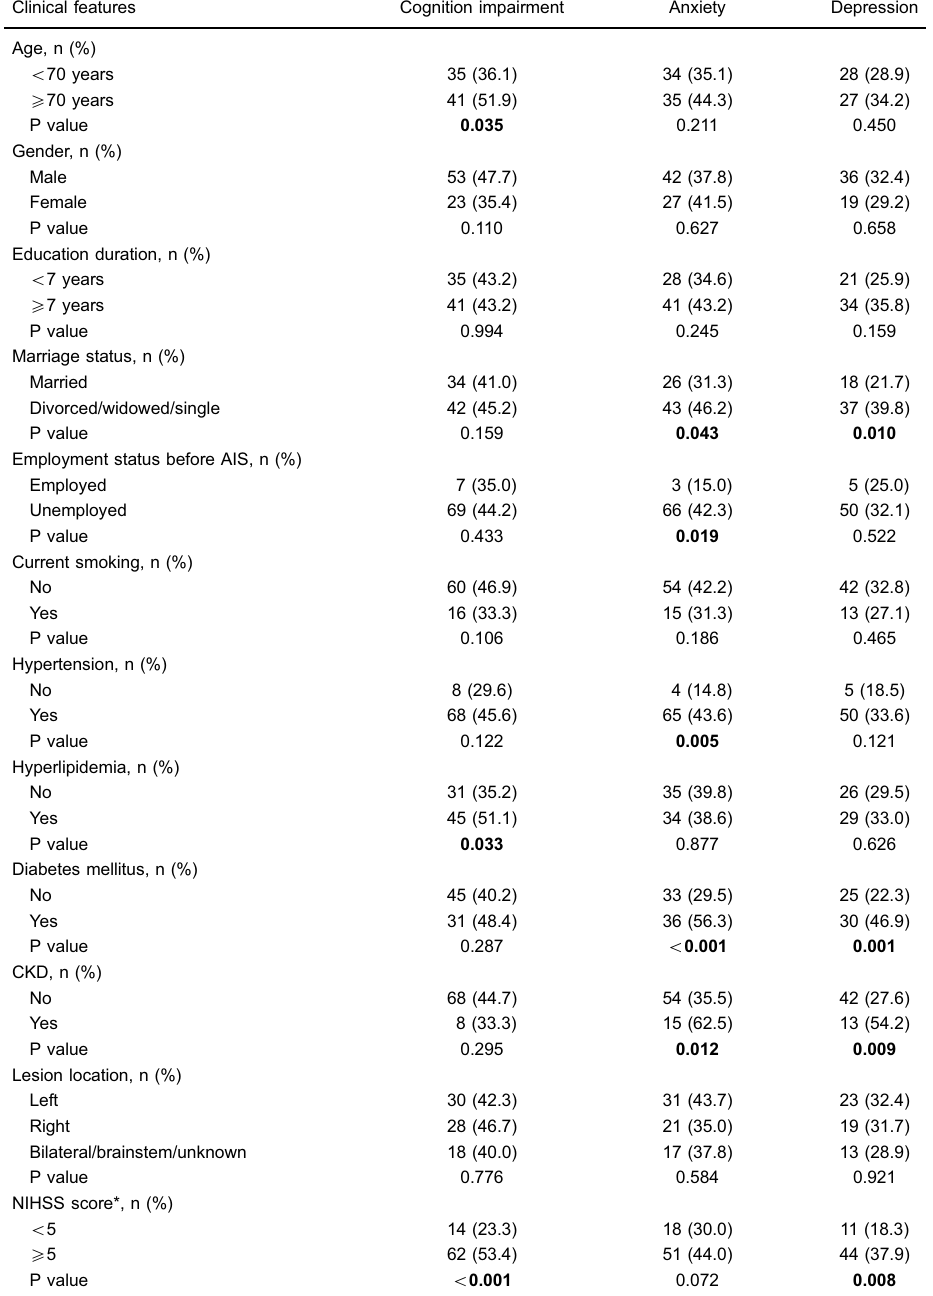
Table 2. Cognition impairment, anxiety, and depression rate among acute ischemic stroke (AIS) patients with different clinical